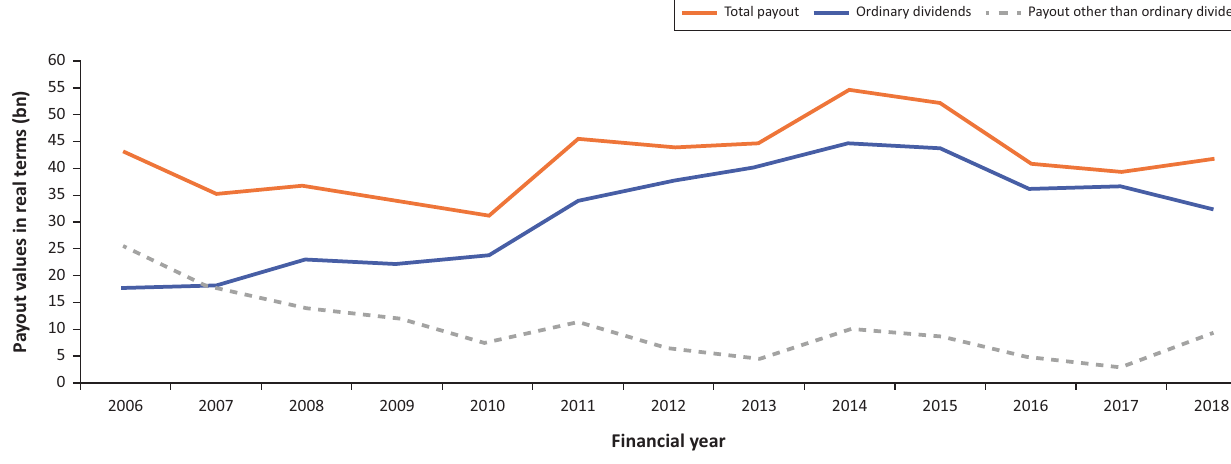
FIGURE 1: Annual payout values from 2006 to 2018.